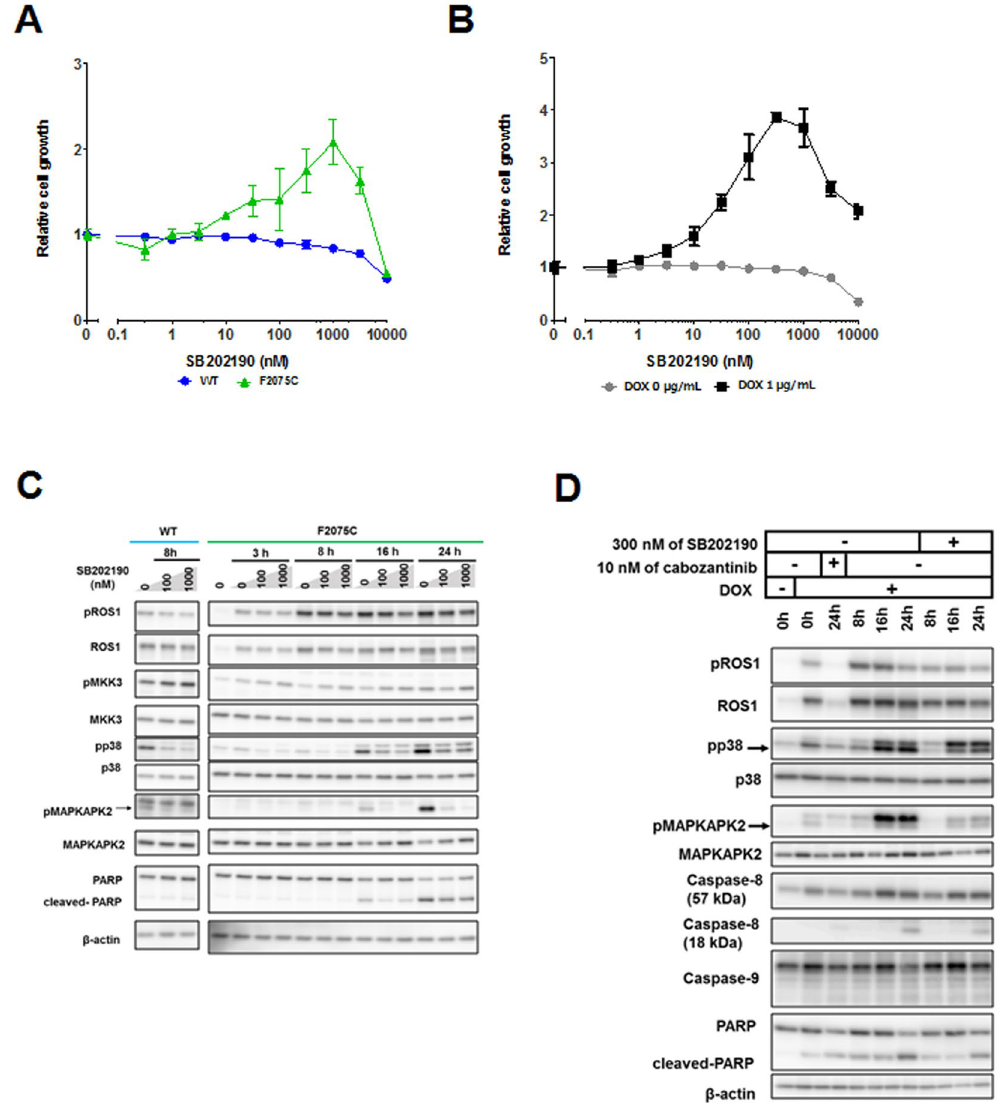
Figure 7. The rescue effect of p38 inhibitor (SB202190) on F2075C-mutated cells obtained by ENU mutagenesis screening or reconstructed F2075C-mutated cells. ( A , B ) Effect of SB202190 on wild-type CD74- ROS1, ENU-screened F2075C-mutated cells ( A ), or reconstructed F2075C cells with or without 1 μ g/mL DOX ( B ). Each cell line was treated with the indicated dose ranges of inhibitors for 72 h, then cell viability was measured by the CellTiter-Glo assay. Each value is shown as relative cell growth by normalizing with the values of untreated wells. ( C , D ) Immunoblotting of SB202190-treated wild-type CD74-ROS1 cells or F2075C-mutated cell ( C ), or SB202190- or cabozantinib-treated reconstructed F2075C-mutated cells with or without 1 μ g/mL DOX (the cells shown DOX ( + ) were pretreated with DOX for 24 h.) ( D ). Cell lysates were immunoblotted to detect the indicated proteins. Uncropped blots are presented in Supplementary Fig.